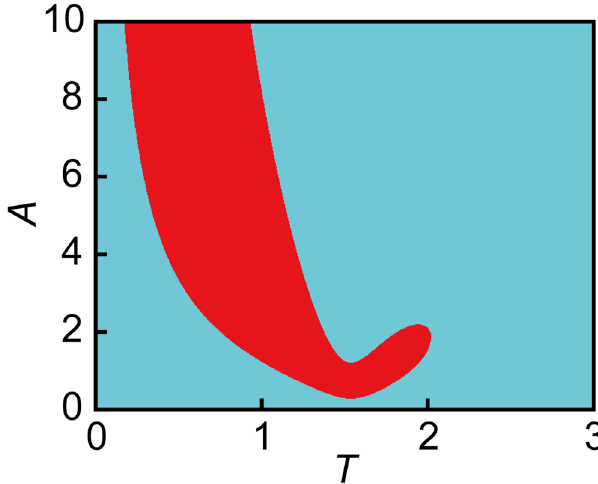
Fig. 5 Phase diagram showing the stability of the uniform oscillatory state in the T - A plane obtained by the linear stability analysis. The cyan and red regions represent the stable and unstable regions, respectively. The parameters are set as a = 22, σ = 8, b = 1.9, c = 1.5, and N =